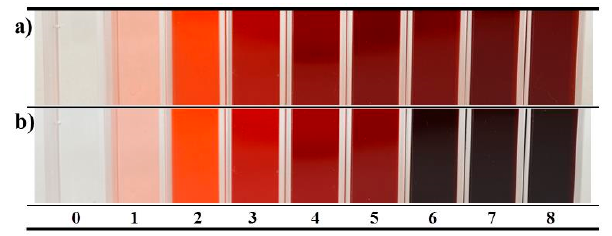
Figure 4. Visual kinetics of colour enhancement. X-axis in days. ( a ) Without surfactant; ( b ) Triton X-100 added at 120 h of fermentation.